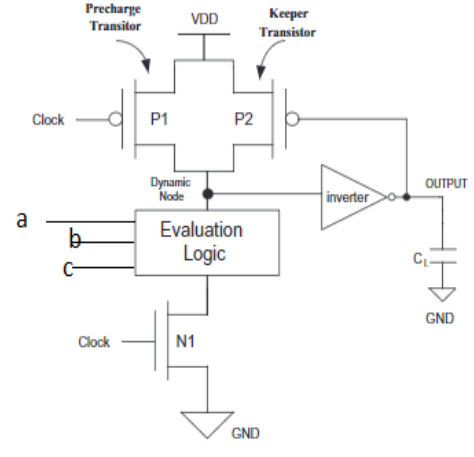
Figure 3. Architecture of Domino Logic with